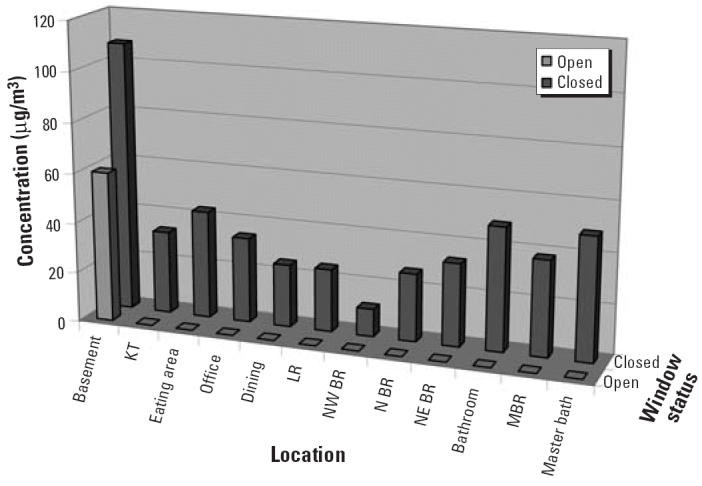
Effect of open windows on airborne mercury concentrations. Abbreviations: BR, bedroom; KT, kitchen; LR, living room; MBR, master bedroom; N, northern; NE, northeastern; NW, northwestern.